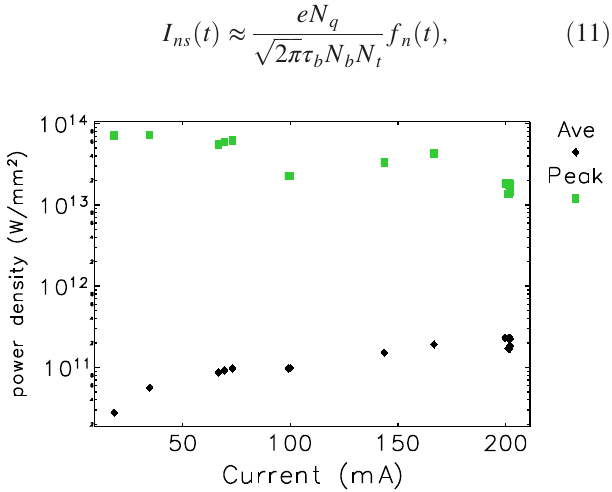
FIG. 36. Average and peak circulating power densities in the 6-GeV electron